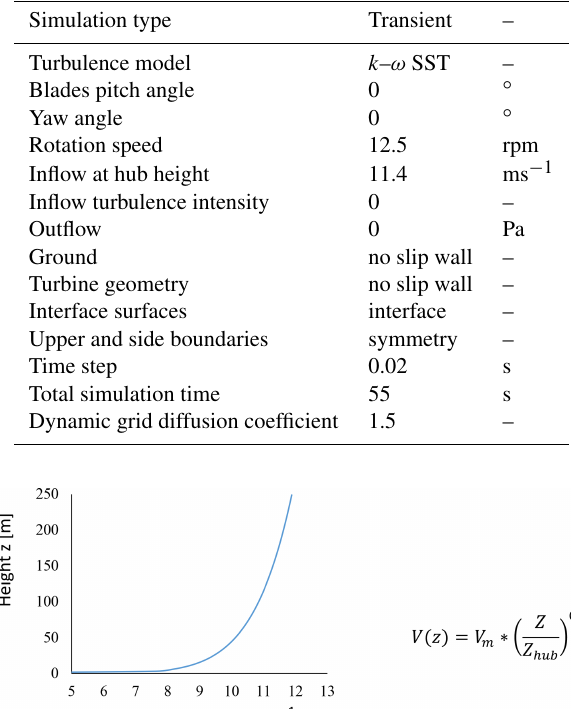
Table 2. Simulation boundary conditions.